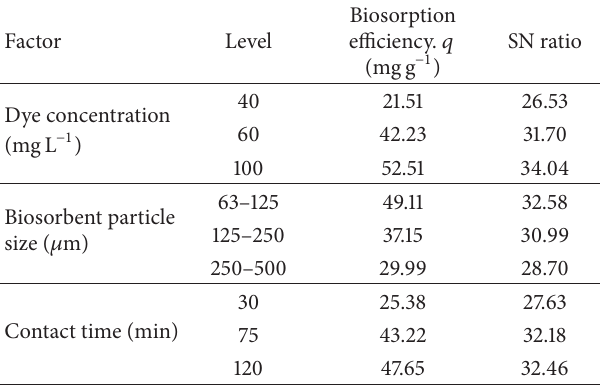
Table 3: Biosorption efficiencies and SN ratio values obtained for all levels of